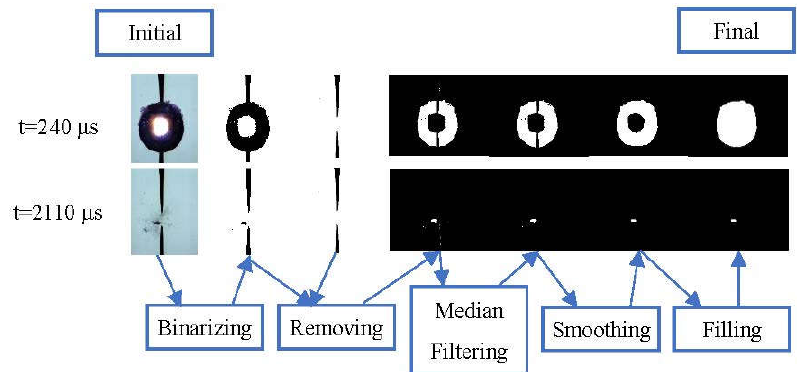
Figure 5. Flow chart, intermediate results and the final result of the image processing algorithm.